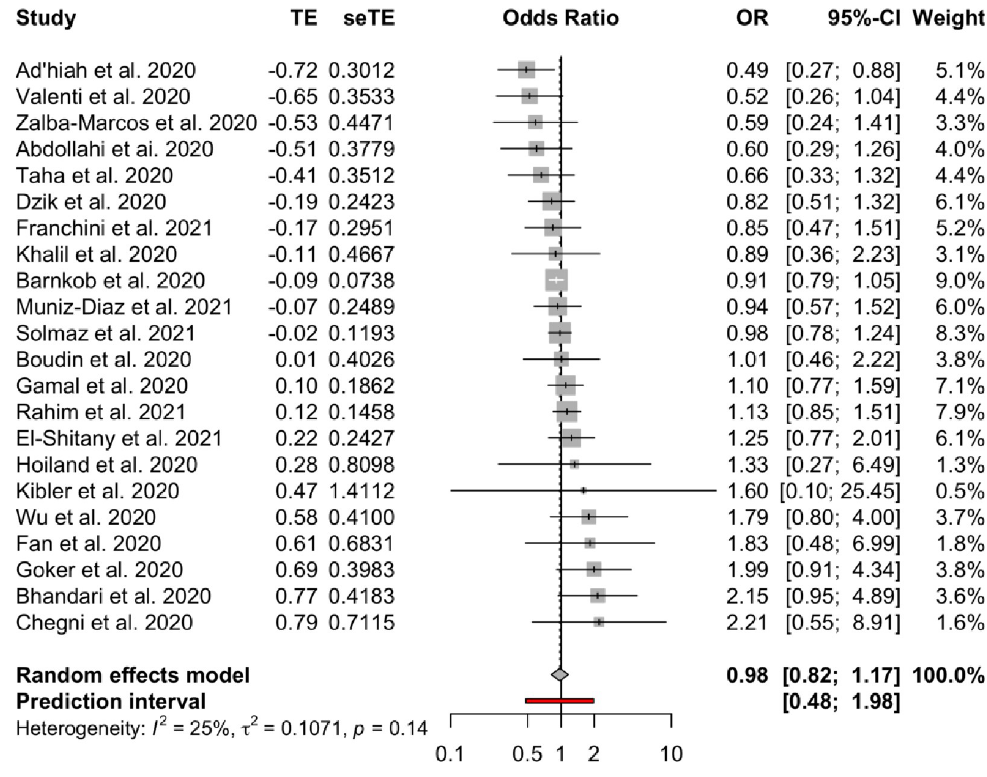
Fig 2. Forest plots for the ABO gene comparison of A vs. AB group.